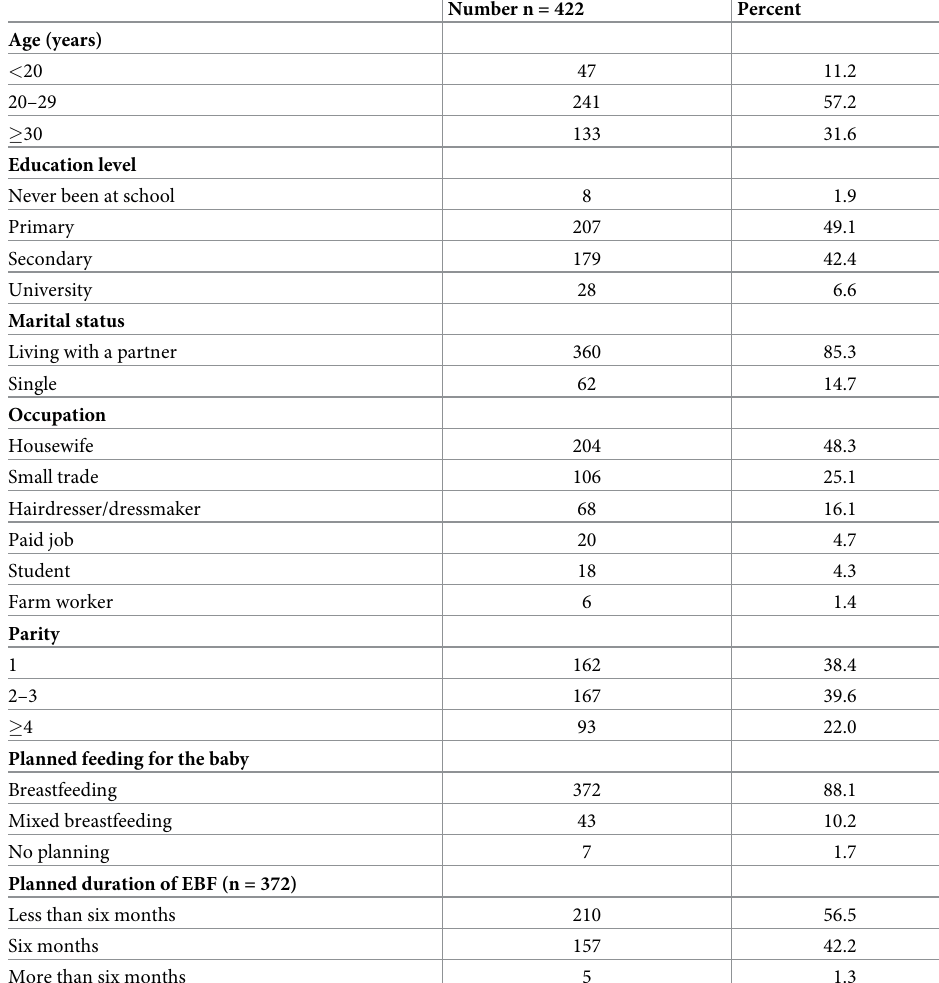
Table 1. Characteristics of study